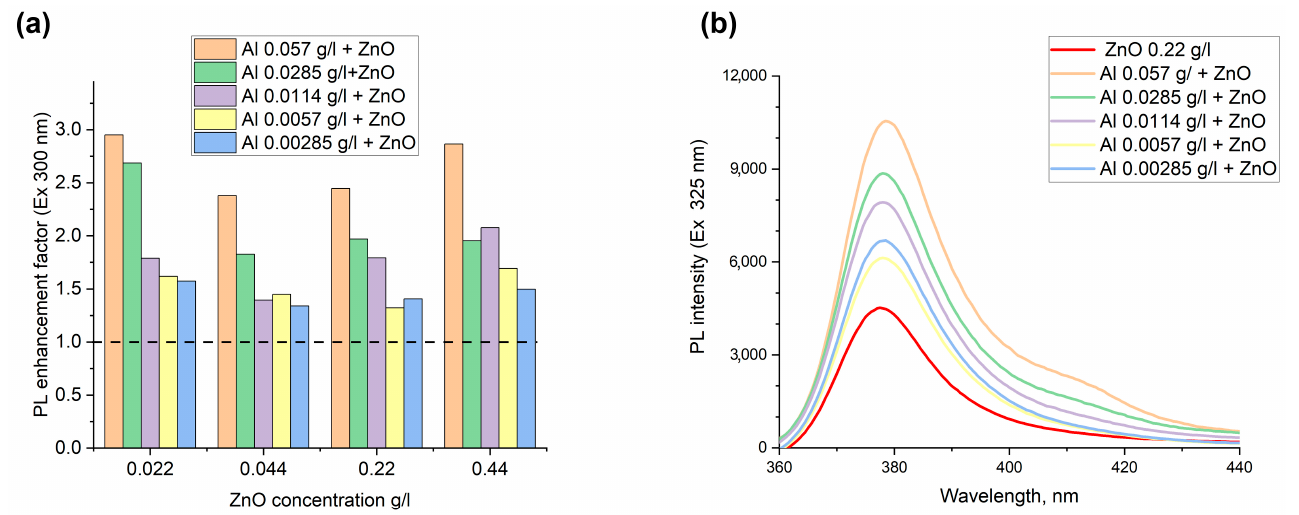
Figure 3. Photoluminescent properties of the colloidal mixture: ( a ) Dependence of the enhancement factor for mixtures with different concentrations of zinc oxide and aluminum oxide nanoparticles; ( b ) Luminescence spectra of pure zinc oxide colloid with a concentration of 0.22 g/L and its mixtures with aluminum colloids of various concentrations (from 0.00285 to 0.057 g/L) at an excitation wavelength of 325 nm.